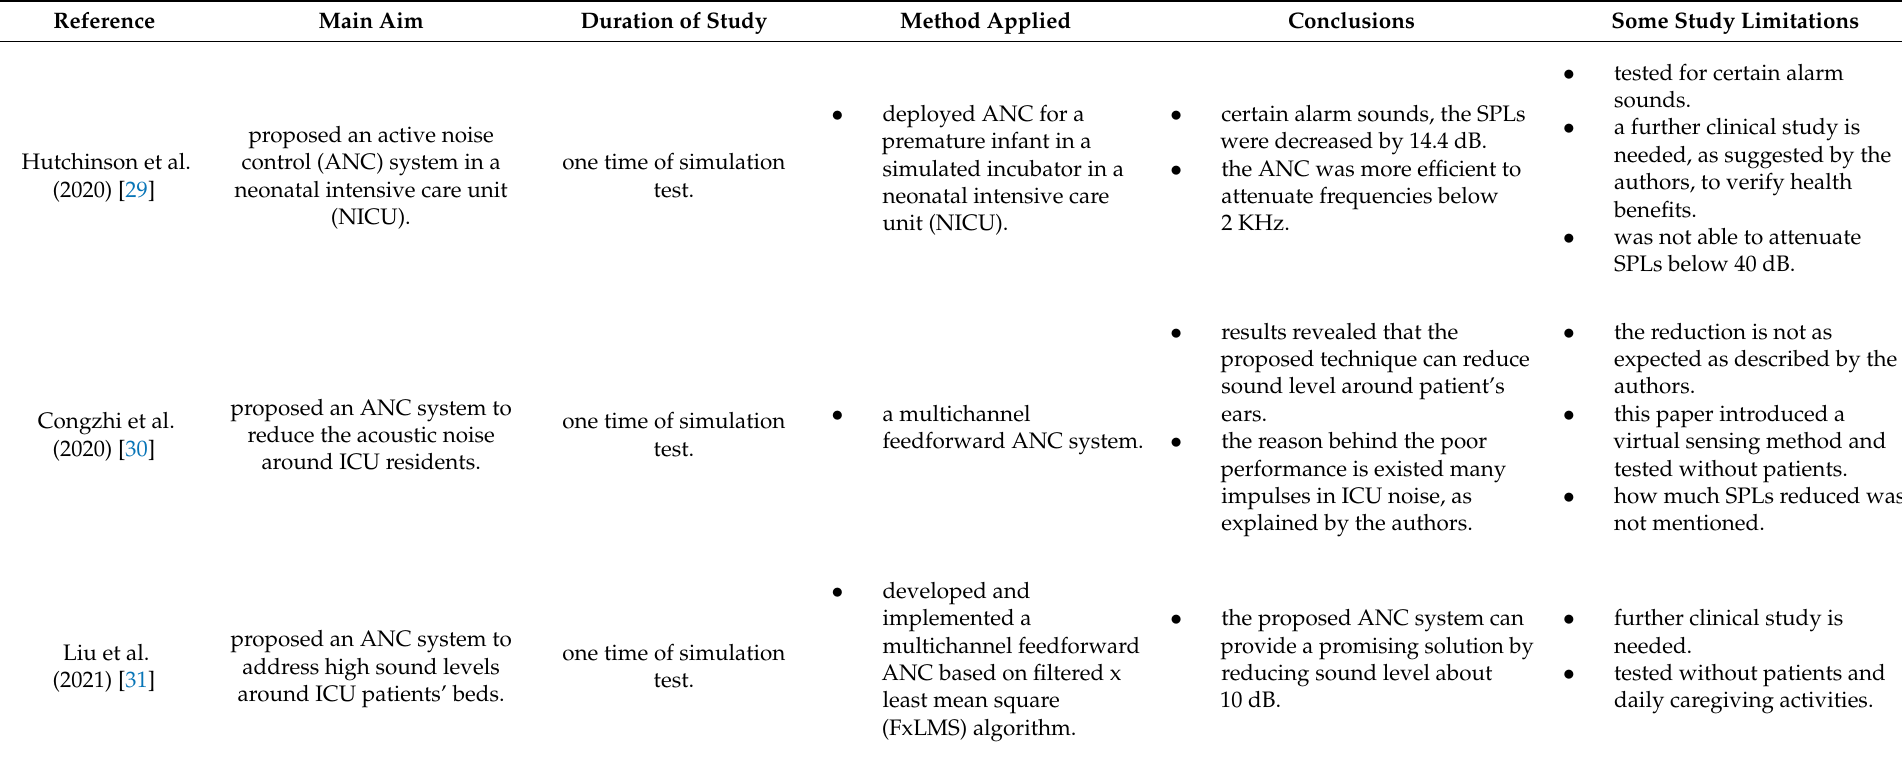
Table 4. Summary of the studies applied ANC